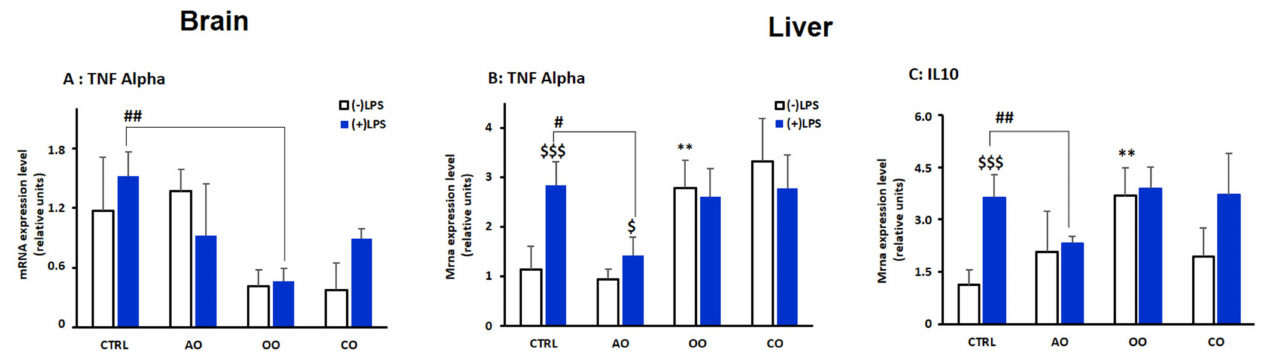
Figure 2. Effect of argan oil, olive oil, or colza oil treatment on gene expression of the proinflammatory marker Tnf- α ( A , B ) in the brain and liver, respectively, and on the anti-inflammatory marker Il-10 in the liver ( C ). Male C57BL/6 mice received for 28 days a standard diet (control (CTRL)), a diet enriched with 6% ( w / w ) AO, OO, or CO, and intravenous injection of LPS (100 µ g) four hours antemortem. First, total RNA was isolated from mice brains or livers, and then the expression level of genes of interest was quantified by real-time RT-qPCR. All values are means ± SD ( n = 3), Statistical significance of higher mean signal strength (** p ≤ 0.01) compared to control, (## p ≤ 0.01. # p ≤ 0.05) Compared to LPS and ($$$ p ≤ 0.001. $ p ≤ 0.05) compared to the different treatments with or without LPS